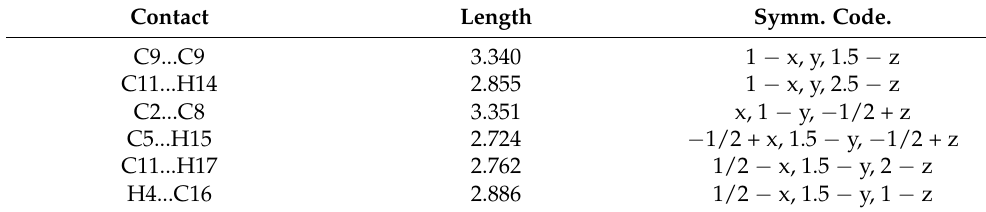
Figure 4. Other H...C and C...C contacts ( upper ) and molecular packing ( lower ) via these interact Table 1. Table 2. Other important contacts and the corresponding interaction distances (Å) for 1